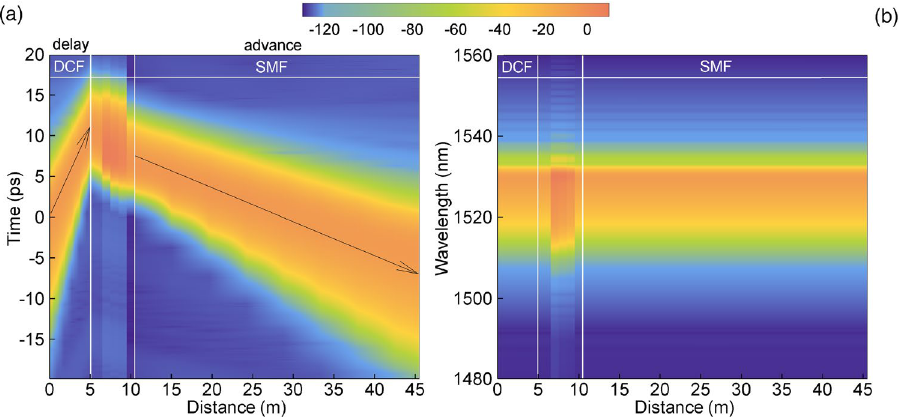
Figure 4. Evolution of the pulse power ( a ) and power spectral density ( b ) along the fiber sections.